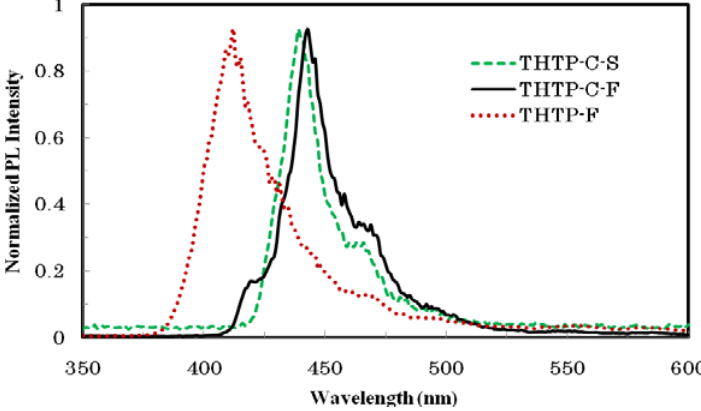
Figure 3. Normalized photoluminescence (PL) spectra: THTP-C in chloroform (THTP-C-S), THTP-C in film (THTP-C-F) and THTP in film